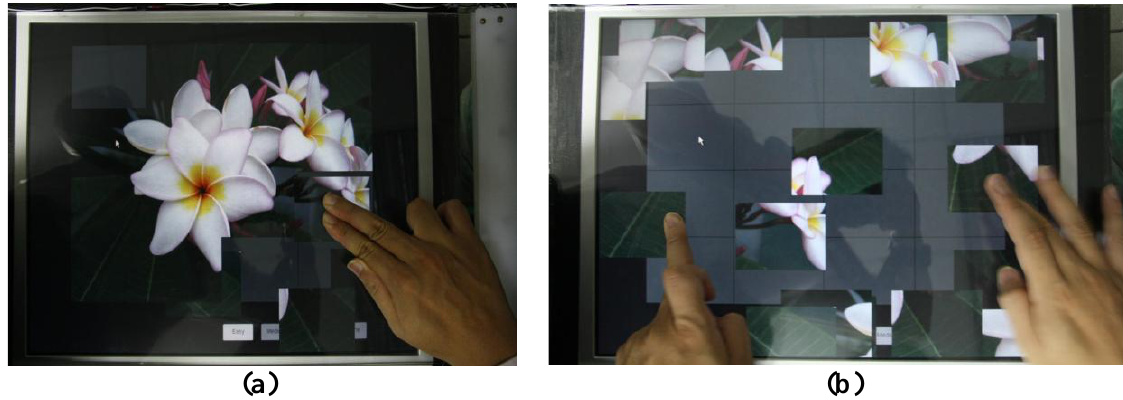
Figure 16. Example of performing the object selecting and moving commands on a puzzle game application using the proposed multi-touch sensing and display system. (a) Selecting objects. (b) Moving and rotating objects.